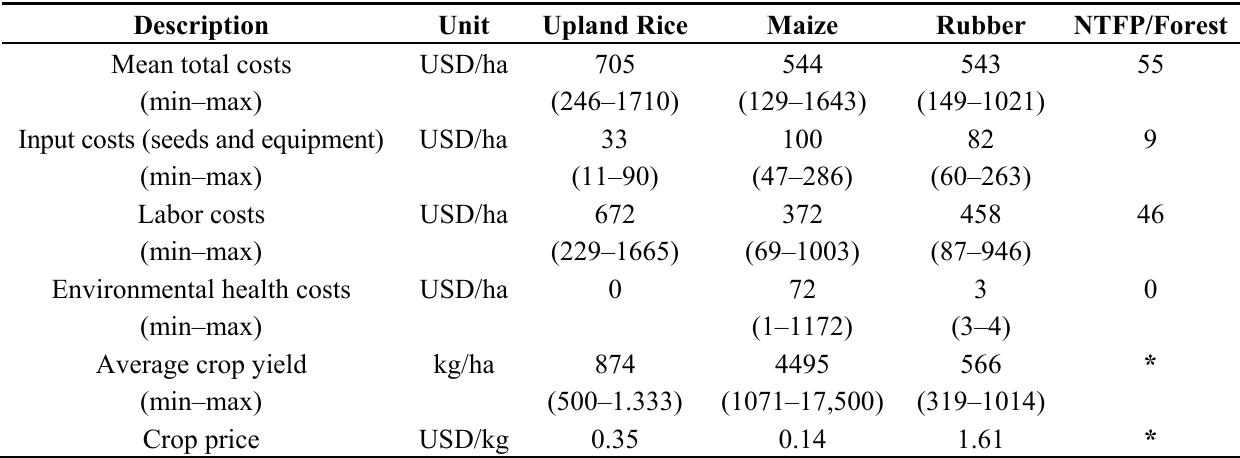
Table 3. Costs and production values used in Net Present Value (NPV) analyses. Source: Field survey data